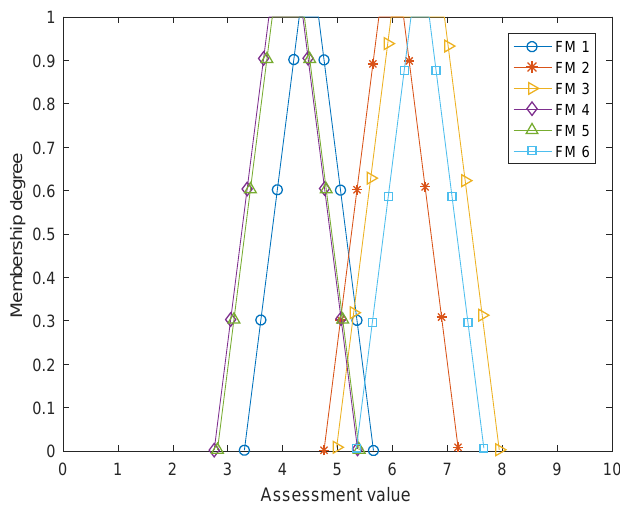
Figure 4. Graphically presentation of fuzzy aggregated evaluations.